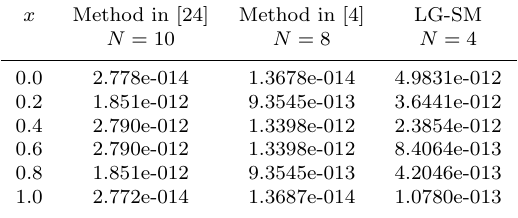
Table 5. Absolute errors of Example 3 using methods in [4,24] and LG-SM for t = 0 .